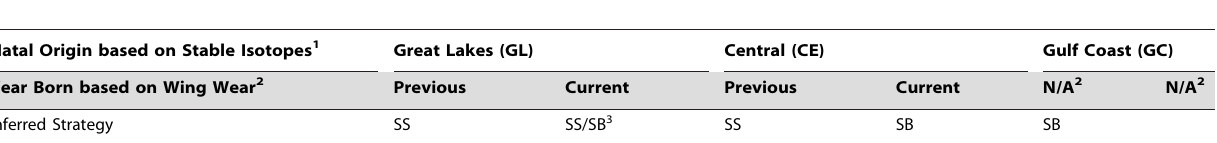
Table 1. Summary of predictions (first two rows) to distinguish whether monarchs arriving in northern portion of the breeding range adopt a single sweep (SS) or successive brood (SB)